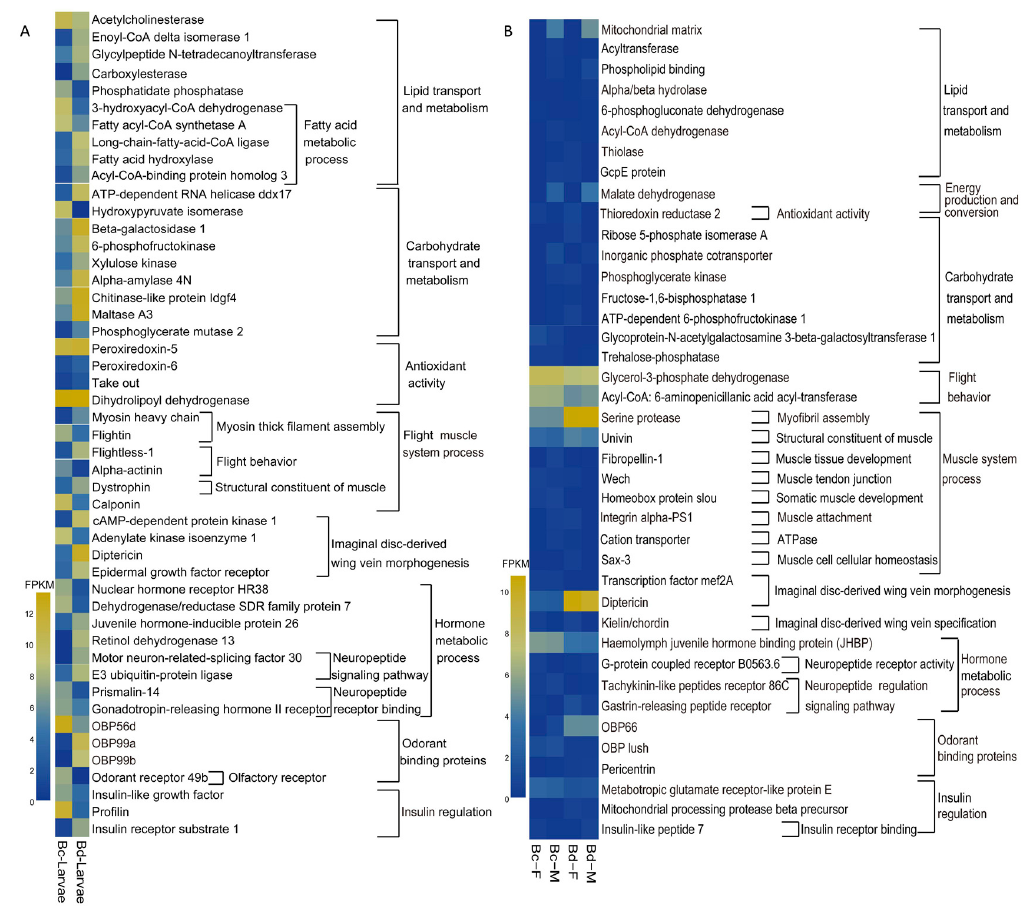
Figure 5. Cont. Figure 5.